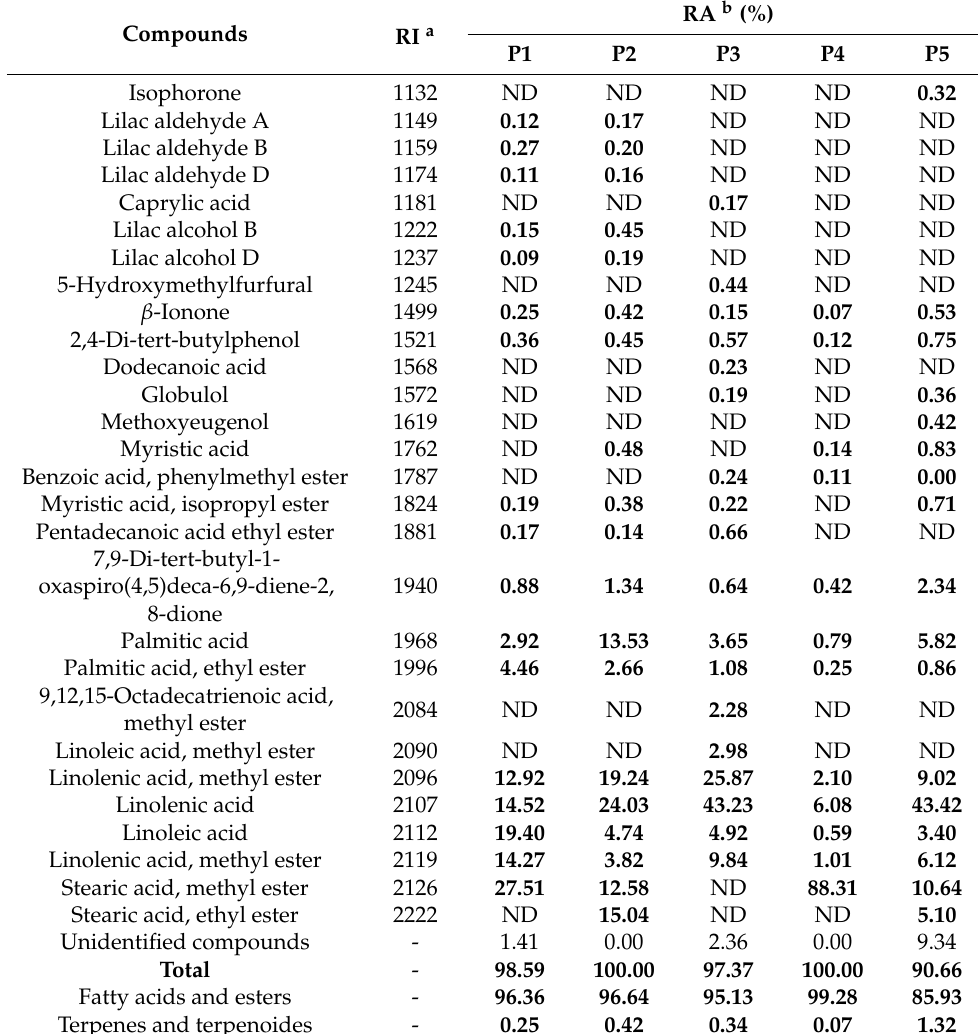
Table 5. Processed BPE